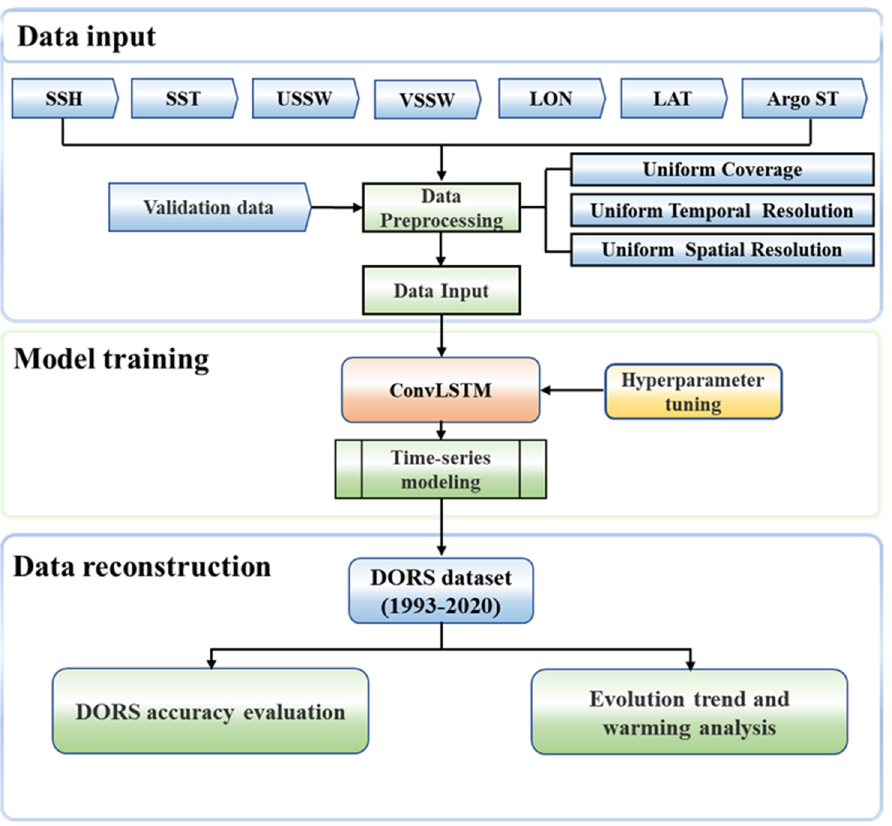
Figure 2. Technical flowchart for satellite-based time series reconstruction of global subsurface temperature based on the ConvLSTM model. Table 2. ConvLSTM network